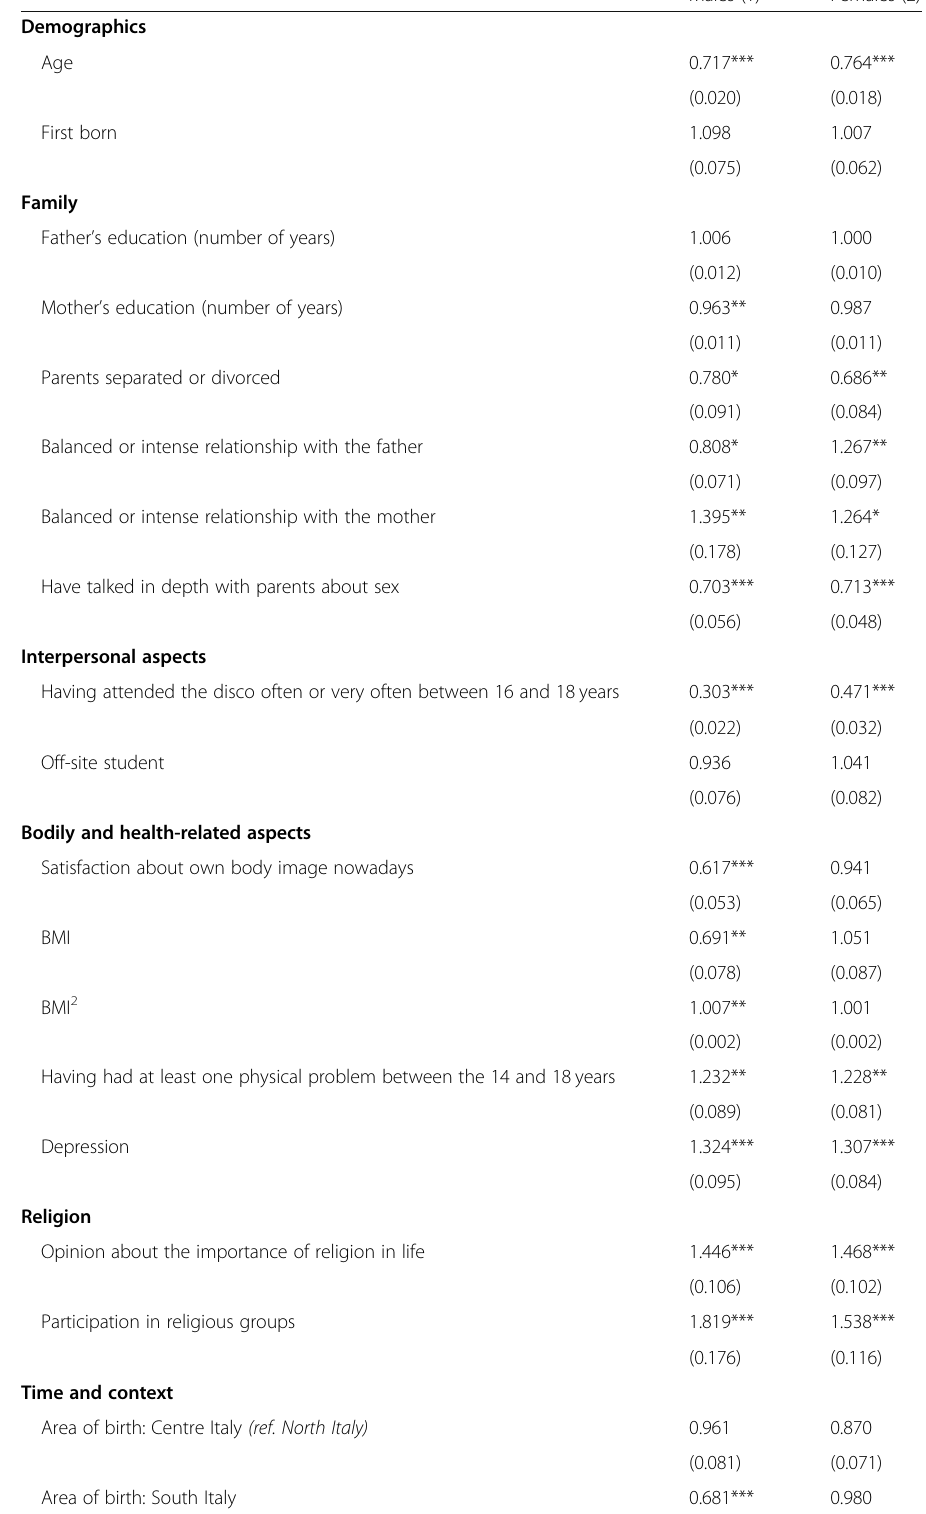
Males (1) Females